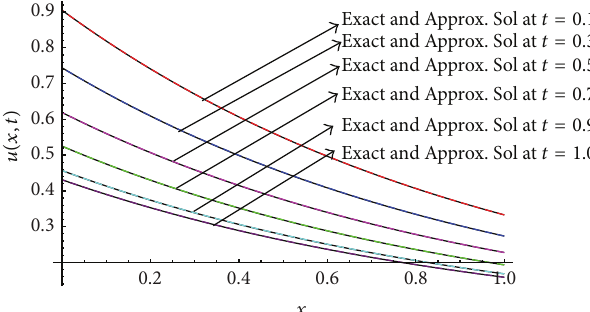
Figure 2: A comparison of numerical solution and known solution at different time levels for Example 1 with ℎ = 0.05 and 𝑘 = 0.01